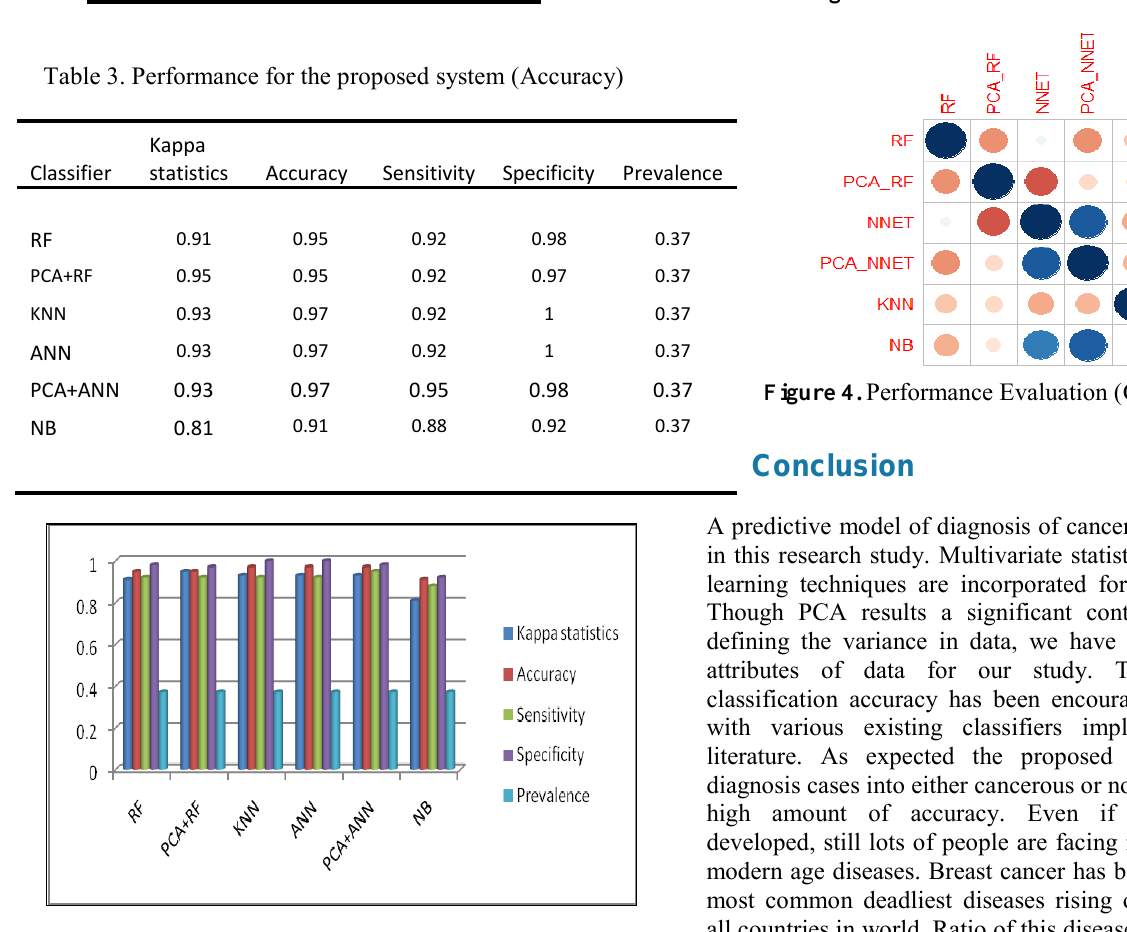
Figure 3. Models evaluation with ROC